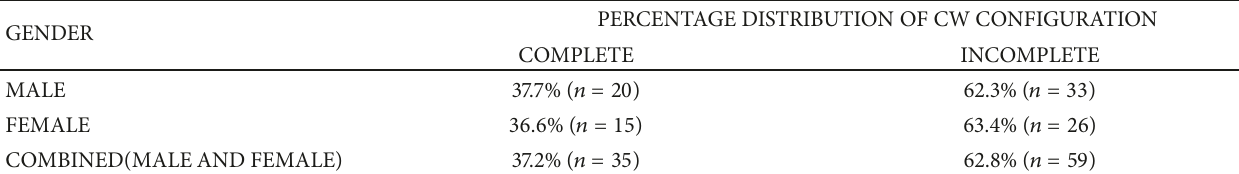
Table 1: Percentage distribution of complete vs incomplete CW in males vs female patients.